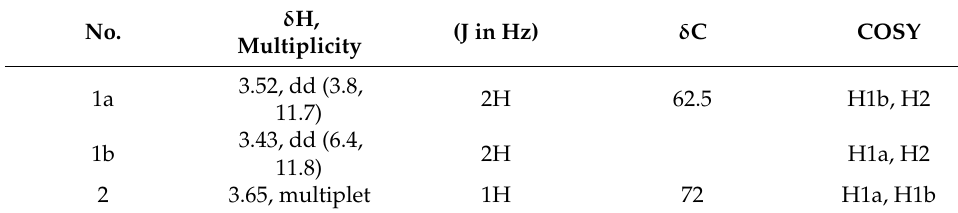
Table 2. NMR data for the compound.